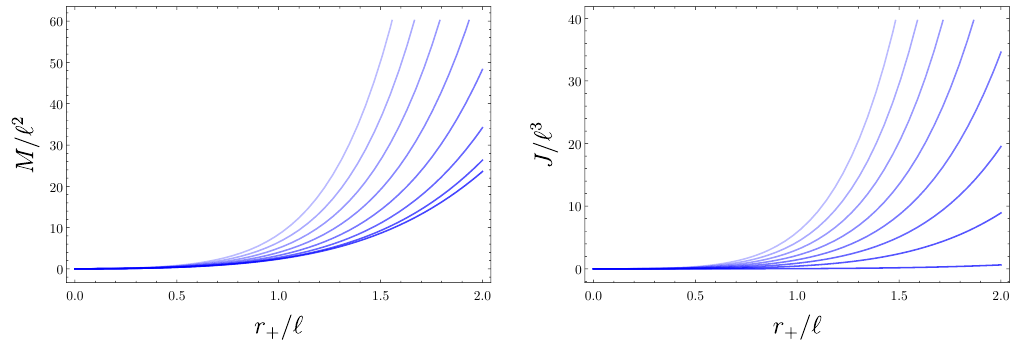
Figure 1. Left: a plot of the mass as a function of horizon radius for several values of r − /r + . Right: a plot of the angular momentum as a function of the horizon radius for several values of r − /r + . In each case, the lower dark blue curve corresponds to r − /r + = 1 / 100 , and this value increases in increments of 1 / 8 as one moves vertically in the plot (lines of decreasing